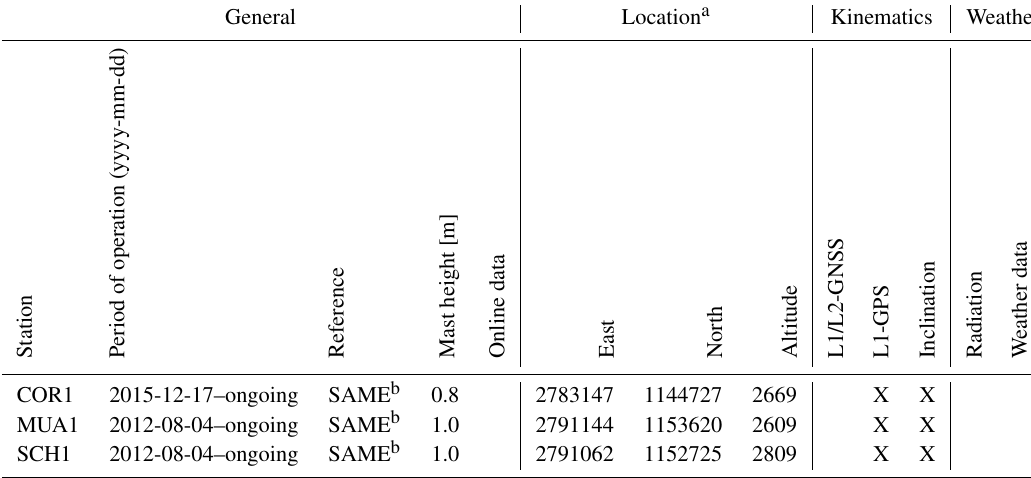
Table A6. Per position overview of the sensors in the Engadine field site. General Location a